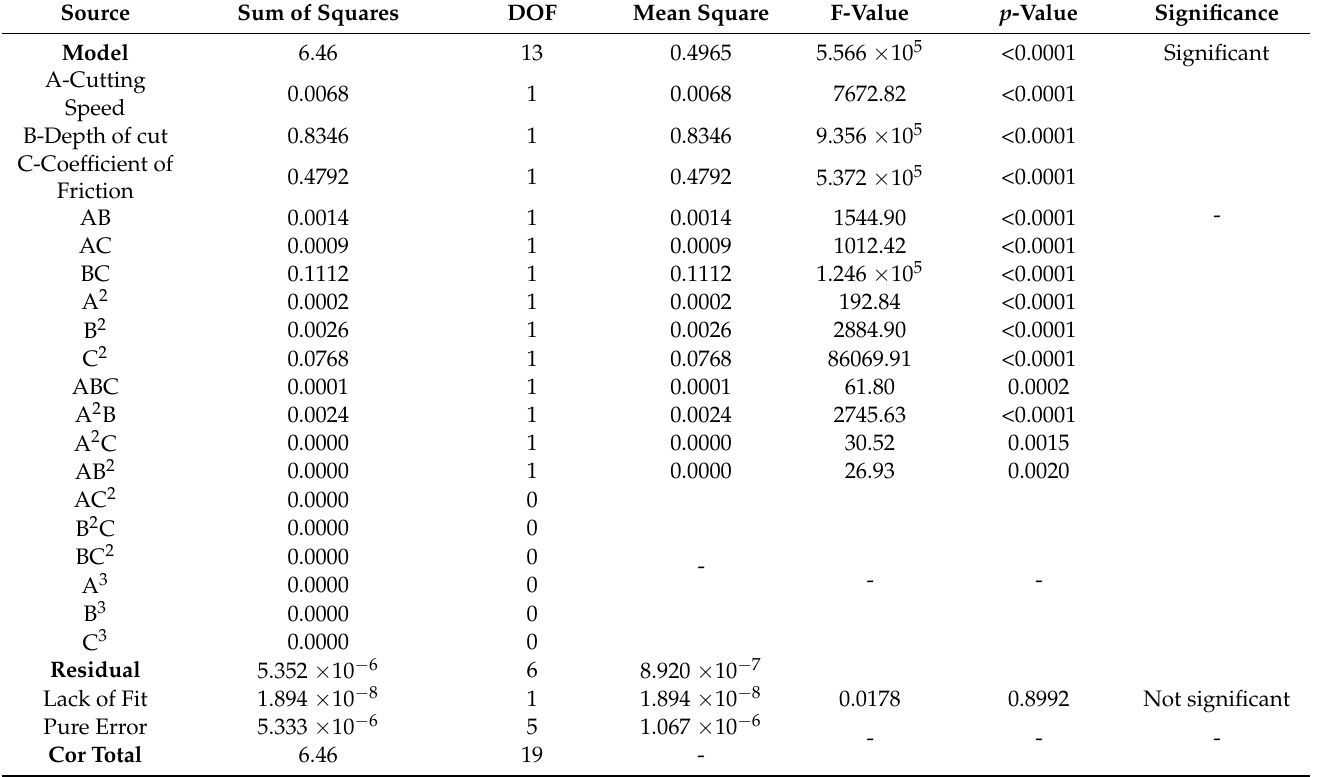
Table 4. Results of ANOVA for cutting force by response surface method